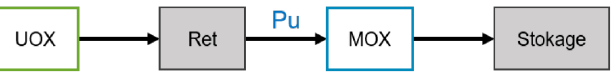
Fig. 3. Fuel cycle of a UOX - MOX fleet. Table 3. SEPAR output for the UOX-MOX mono-